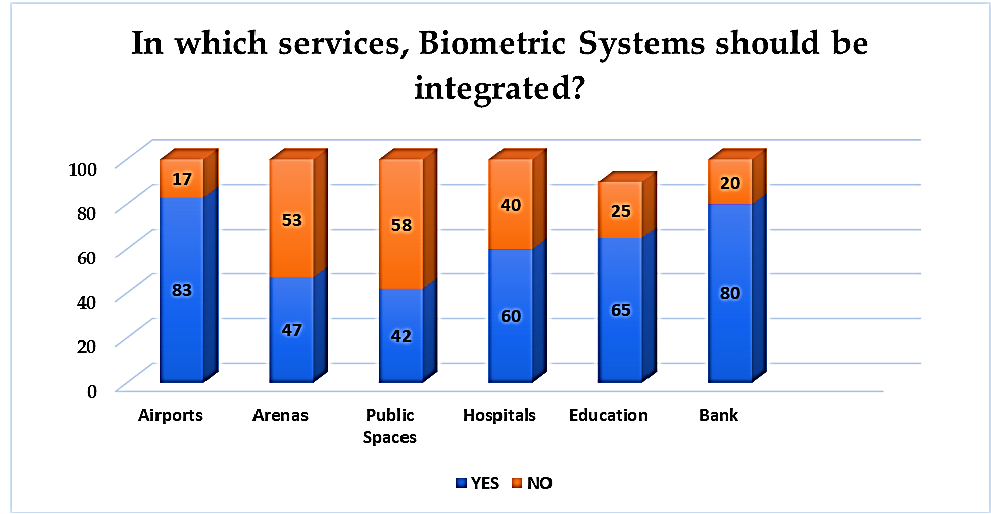
Figure 18. BS perceived integration to services .